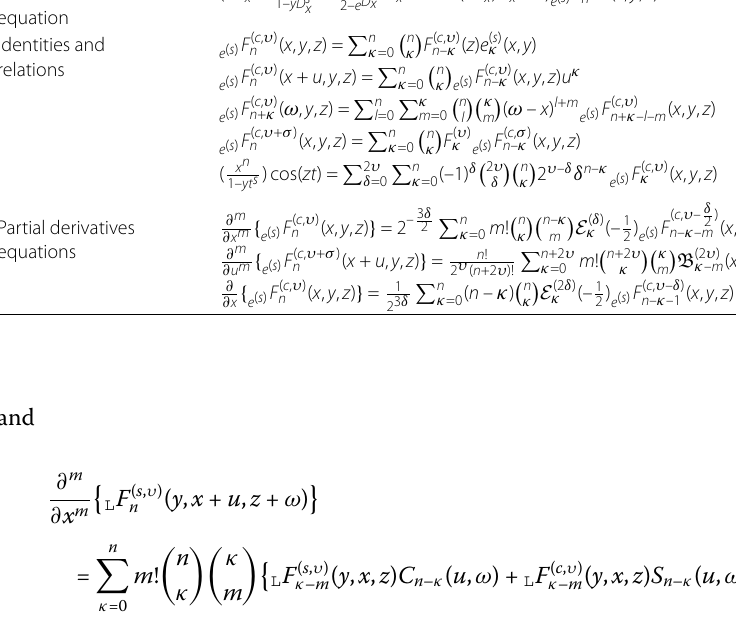
Table 6 Results for Generating function Multiplicative and derivative